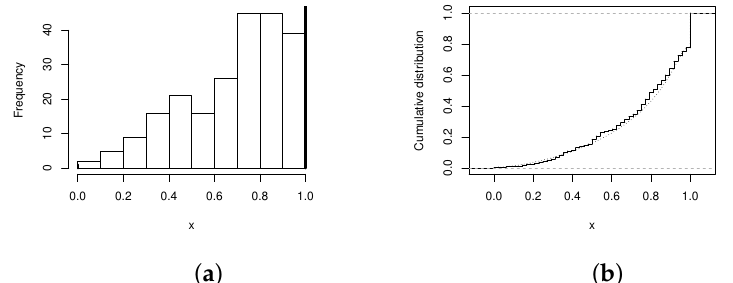
Figure 3. ( a ) Histogram of the the variable X . ( b ) Graphs: empiric (solid line), BUBSZOI (dotted